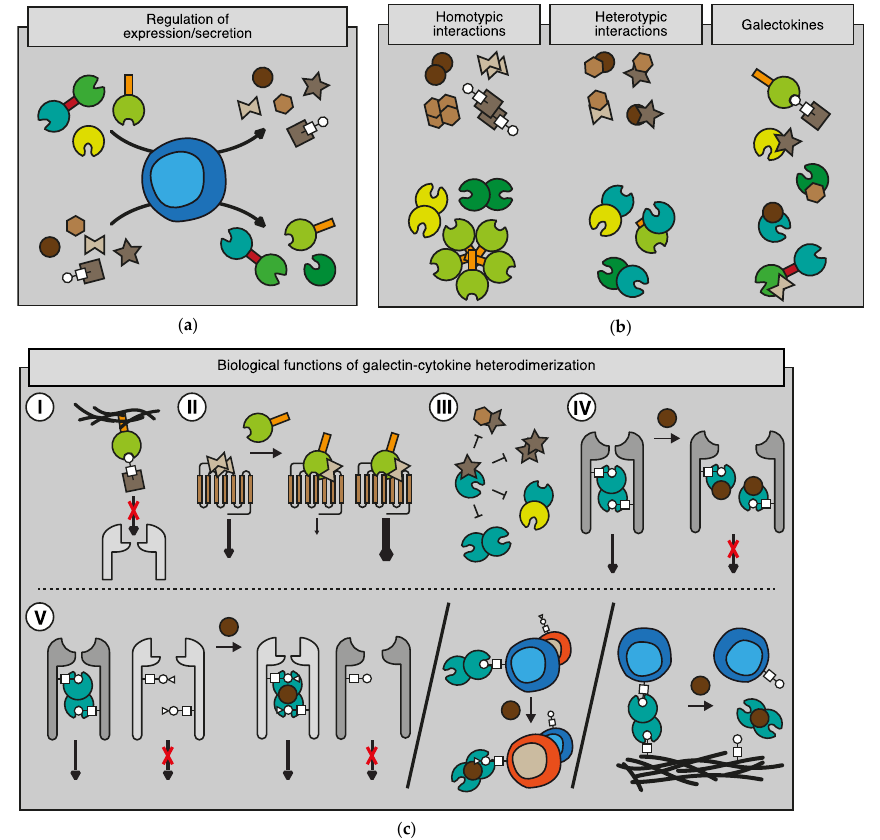
Figure 3. Overview of the reciprocal relationships between galectins and cytokines and the functional consequences of galectin-cytokine interactions. ( a ) Illustration showing the reciprocal expression regulation of galectins and cytokines. ( b ) Illustration depicting the different interactions between galectins and cytokines that have been reported in the literature. This ranges from homotypic interactions within each family (left panel) to heterotypic interactions between members of a specific family (middle panel) as well as heterotypic interactions between members of both families, i.e., galectokines (right panel). ( c ) Illustration of the different functional effects of galectokines. (I) Galectins in the extracellular matrix can capture/scavenge cytokines, thereby hampering cytokine-mediated signaling. (II) Galectin-cytokine interactions can affect the direct binding of cytokines to their receptor, thereby affecting the activity of receptor signaling. (III + IV) Galectin-cytokine interactions can hamper the formation of other functional homo- and/or heterodimers, thereby interfering with the activity of these dimers in e.g., receptor dimerization/signaling. (V) Galectin-cytokine interactions can alter glycan-binding of galectins which might trigger translocation of the heterodimer to other receptors or alter interactions of cells with the microenvironment or with other cells.